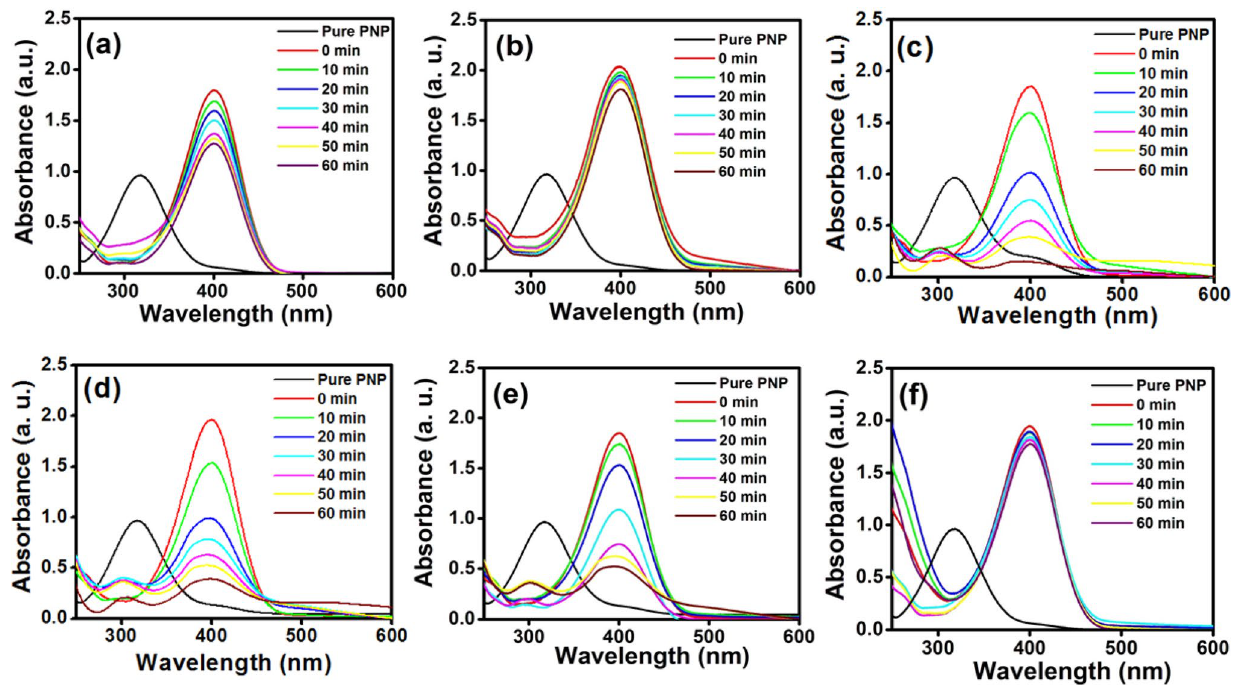
Fig. 5 Photo-degradation study of p-nitrophenol under light illumination containing photocatalyst a Z1, b Z2, c Z3, d Z4, e Z5 and f no cata- lyst